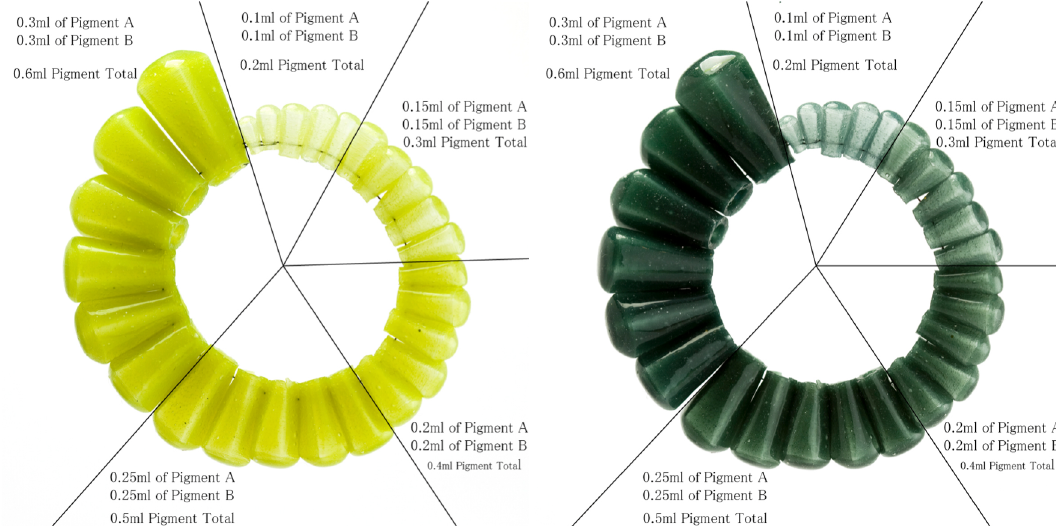
Figure 2 | Example of a Dual Pigment Test: Blue 27˚C and Yellow 38˚C in its unchanged and changed state.